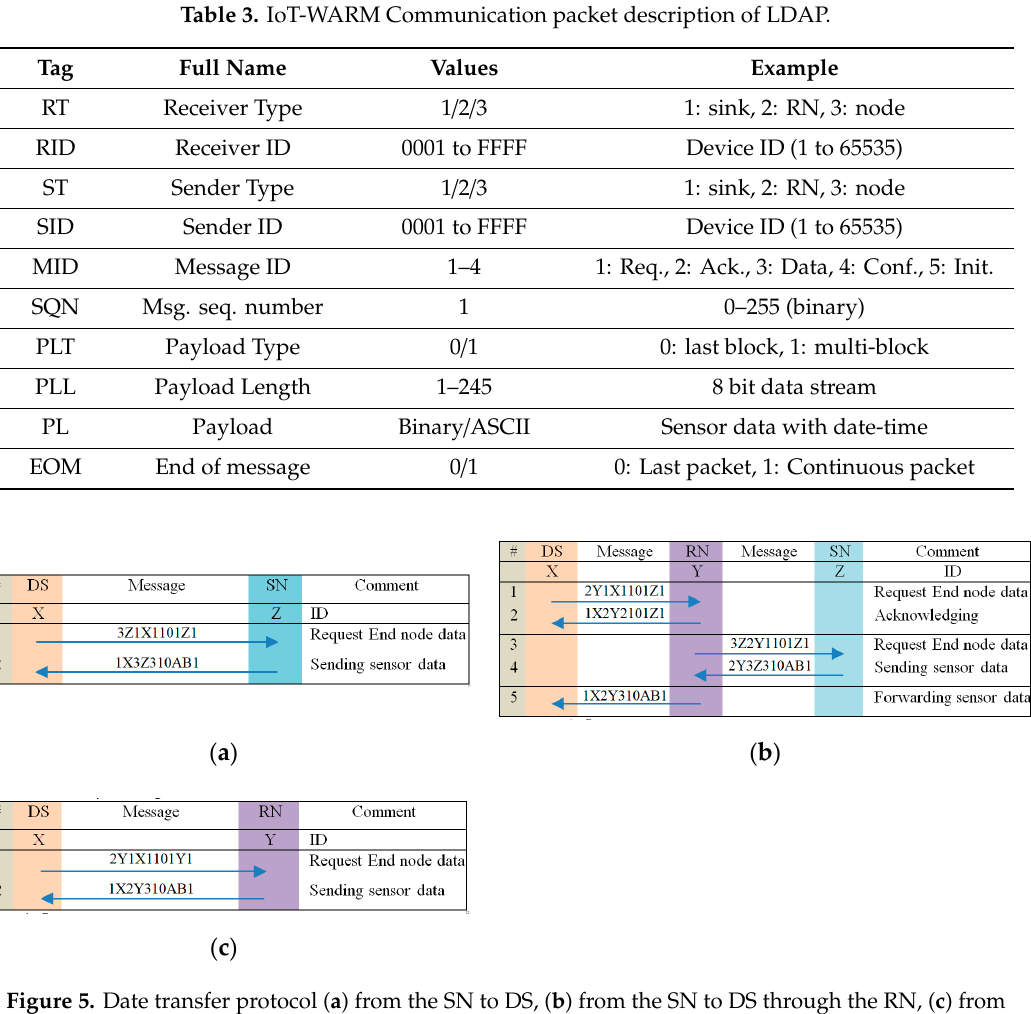
Figure 5. Date transfer protocol ( a ) from the SN to DS, ( b ) from the SN to DS through the RN, ( c ) from the SN to RN.